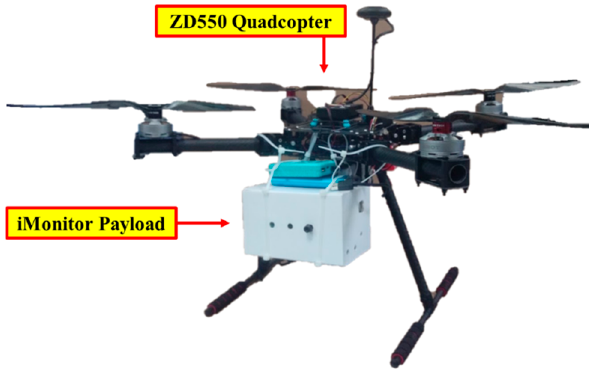
Figure 3. Unmanned aerial vehicle (UAV).